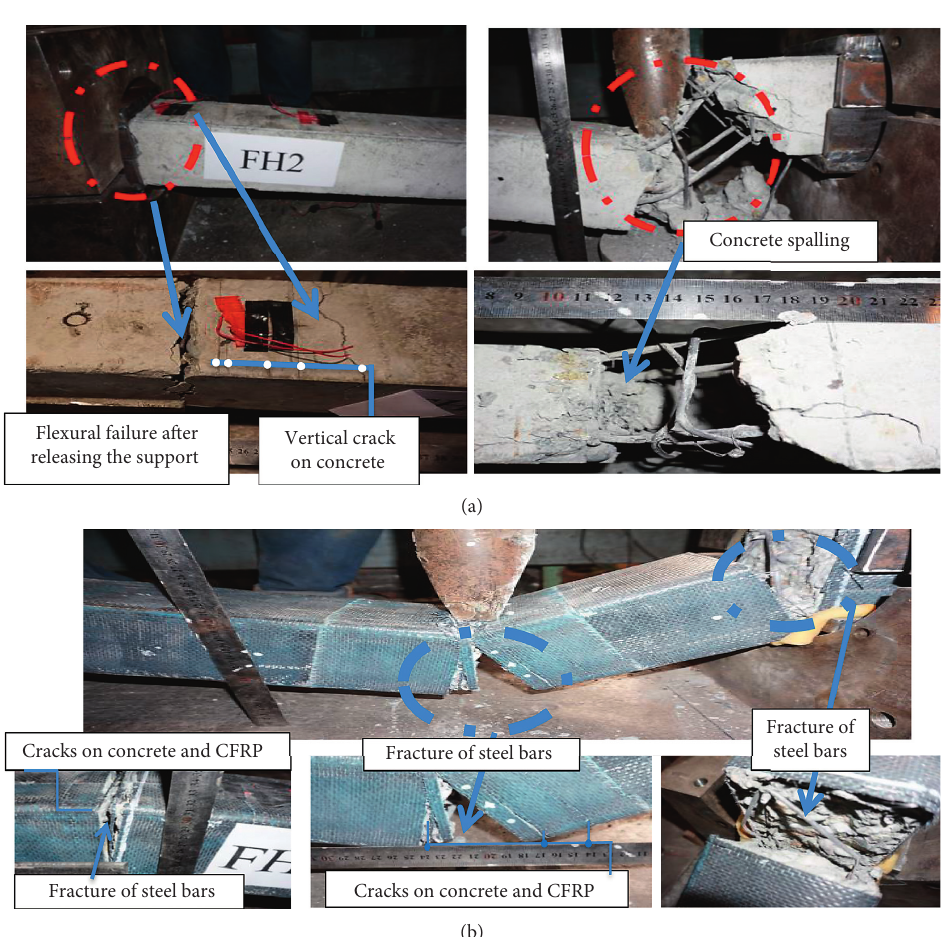
Figure 5: Failure modes for specimens after impact. (a) FH2 Unstrengthened specimen. (b) FH2-H1 CFRP-shear-strengthened specimen.